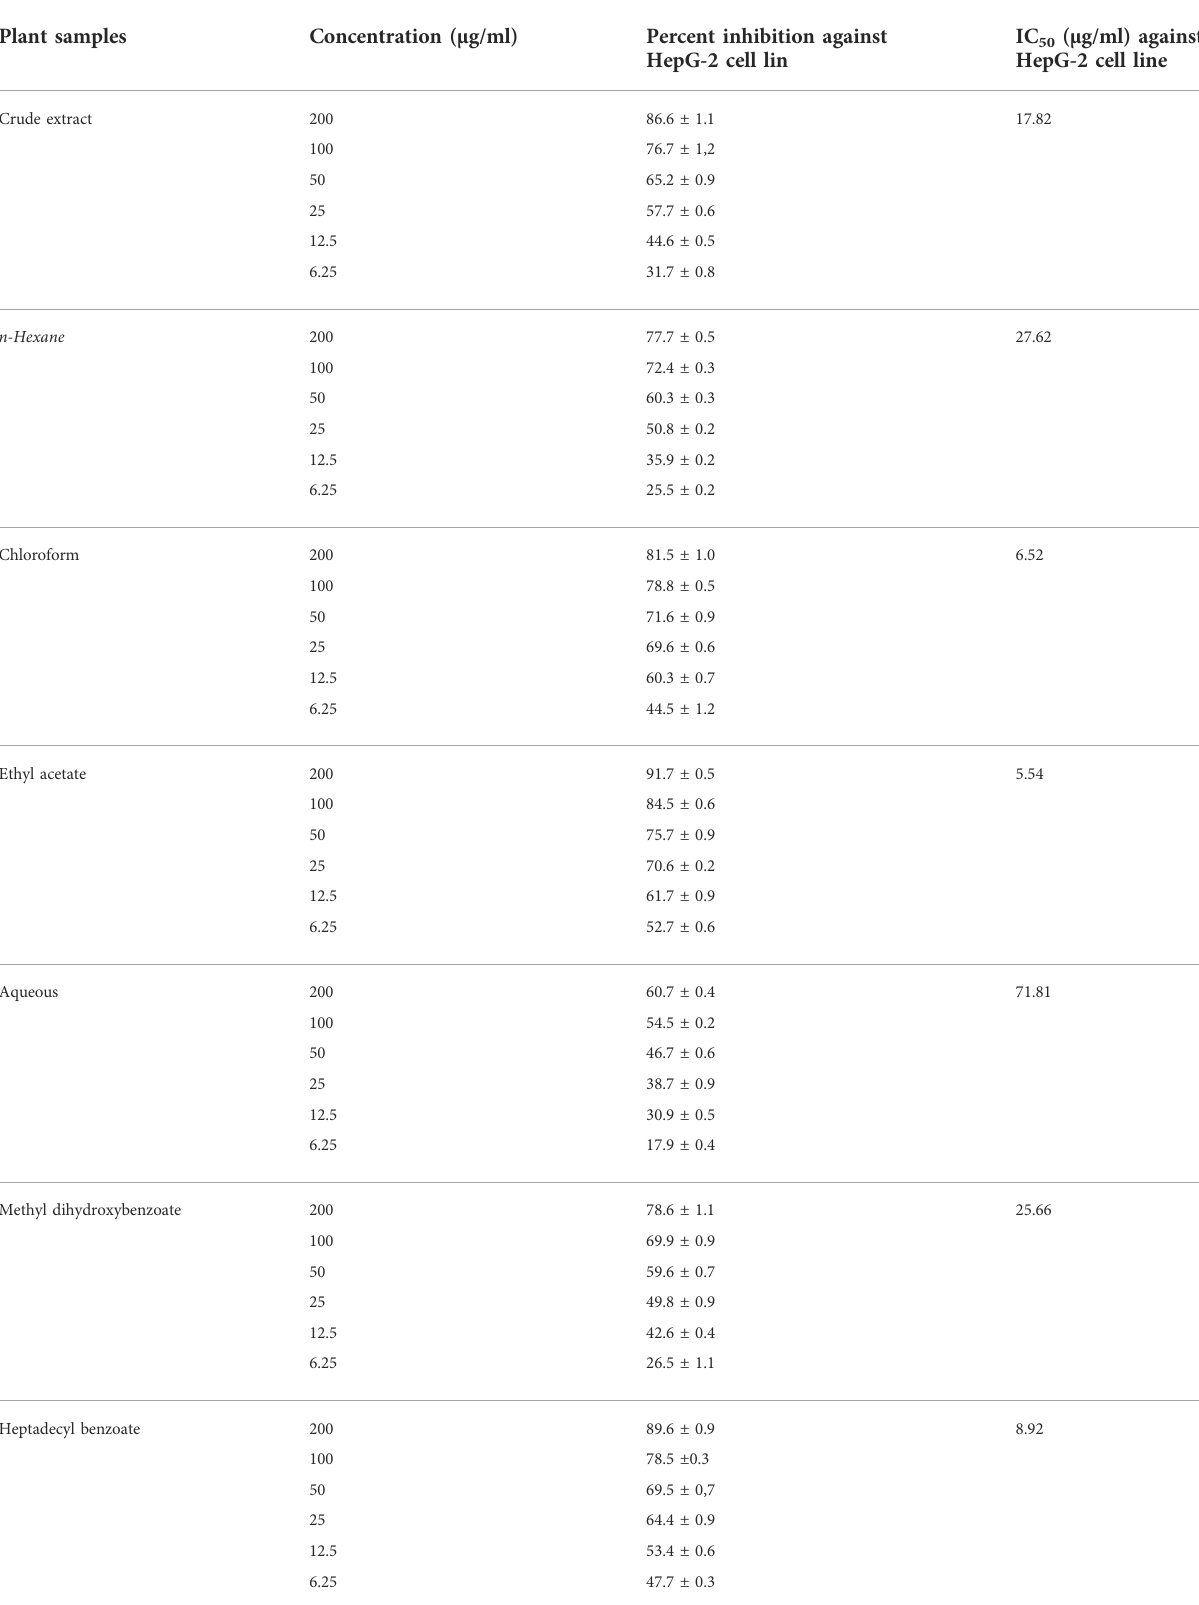
TABLE 1 I. spicata fractions and compounds cytotoxicity against HepG-2 cell line. Plant